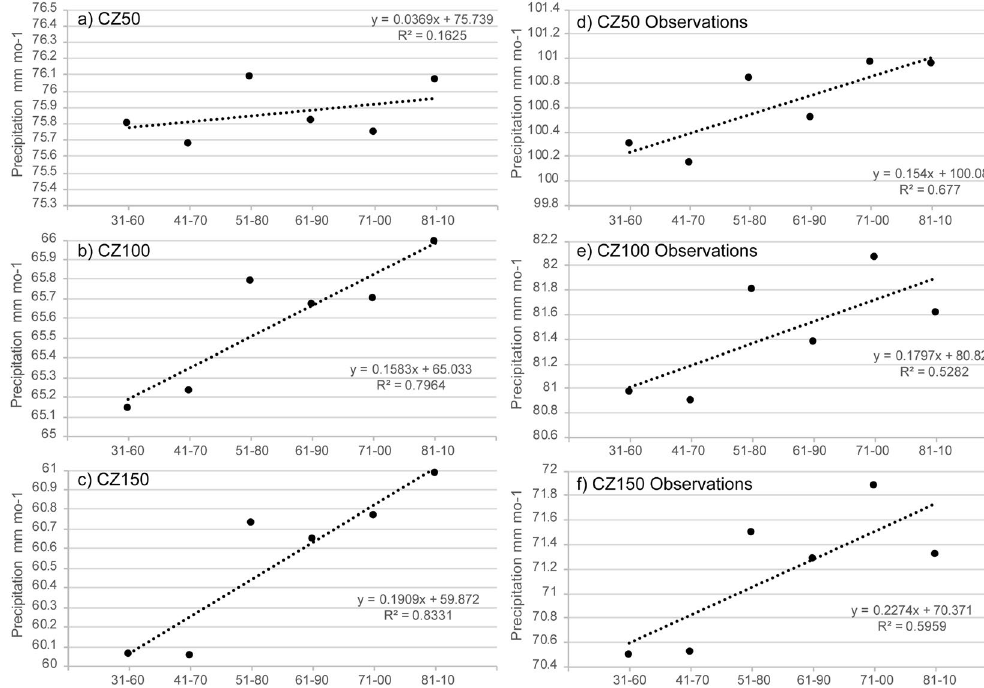
Figure 5. Thirty-year precipitation averages with a 10-year sliding window from 1931–1960 to 1981–2010 of CZ50, CZ100, and CZ150 for the analysis product ( a – c ) and observation grid boxes covering the entire 1931– 2010 time period ( d – f ). Linear trend lines, with equation and r 2 value, are included in each